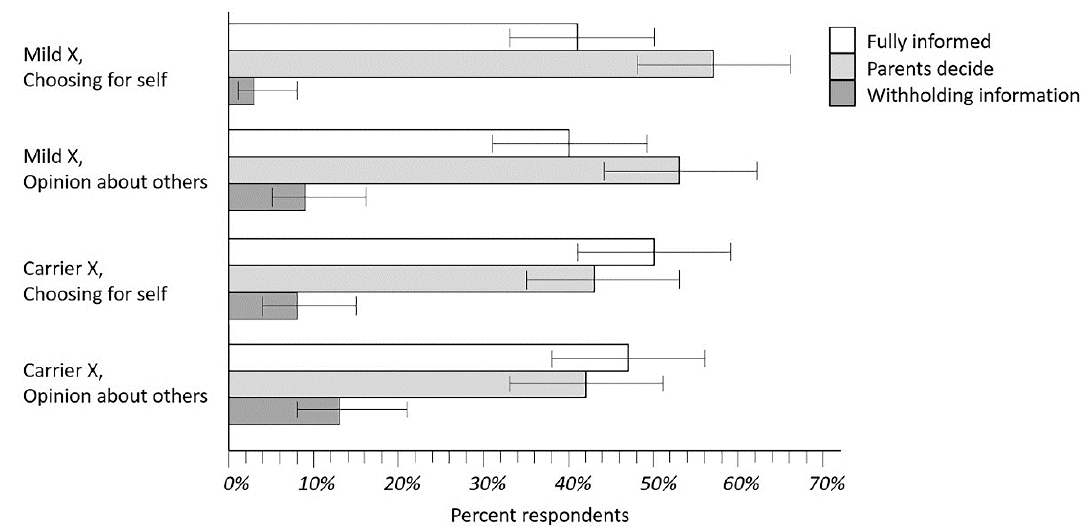
Figure 4. Rankings of disclosure policies for Mild X and Disease X carrier status. Results shown are from respondents asked to rank their preferences for disclosure of policy options that could be implemented by caregivers for either a Mild X condition analogous to CRMS/CFSPID or Disease X like CF. The intent of this exercise was to learn what parents preferred and what they were opposed to as well: clearly, the Withholding Information policy option.